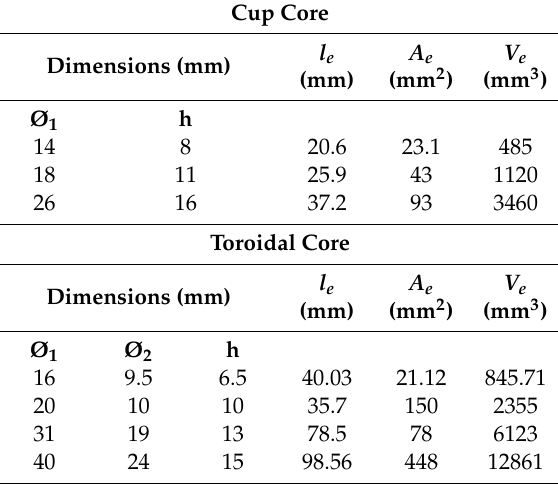
Table 2. Geometrical parameters of the tested inductor cores.